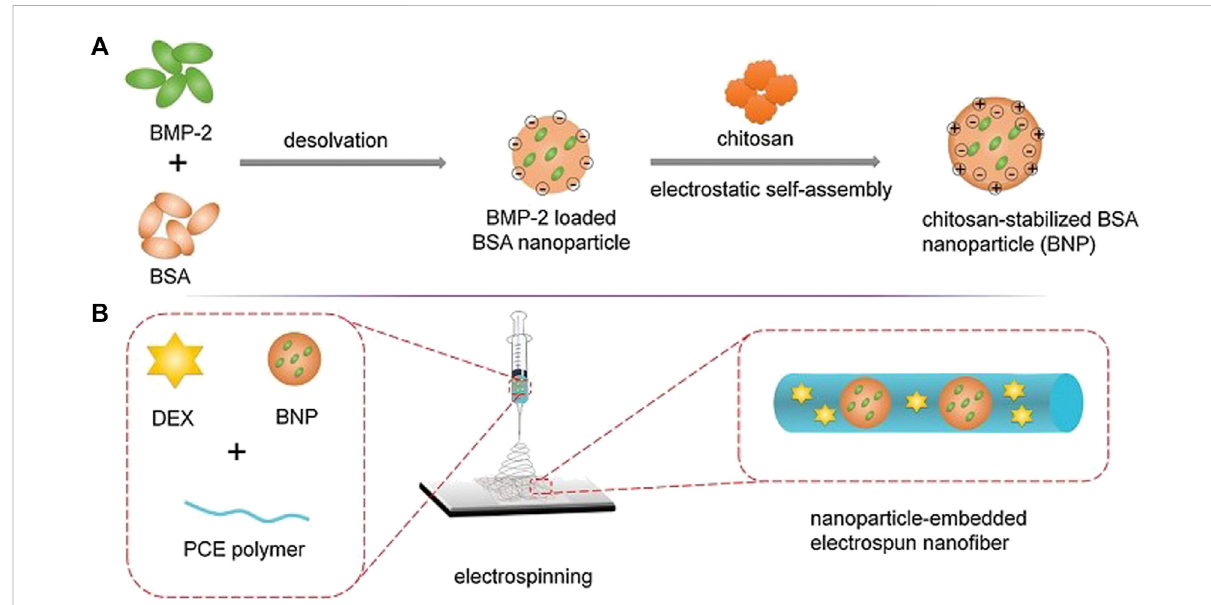
FIGURE 12 Illustration depicting the (A) Synthesis of BMP-2 loaded BSA nanoparticles (B) Nanoparticle embedded electro spun nano fi ber (Reproduced with permission from Ref (Li et al., 2015). Copyright © 2014 Elsevier